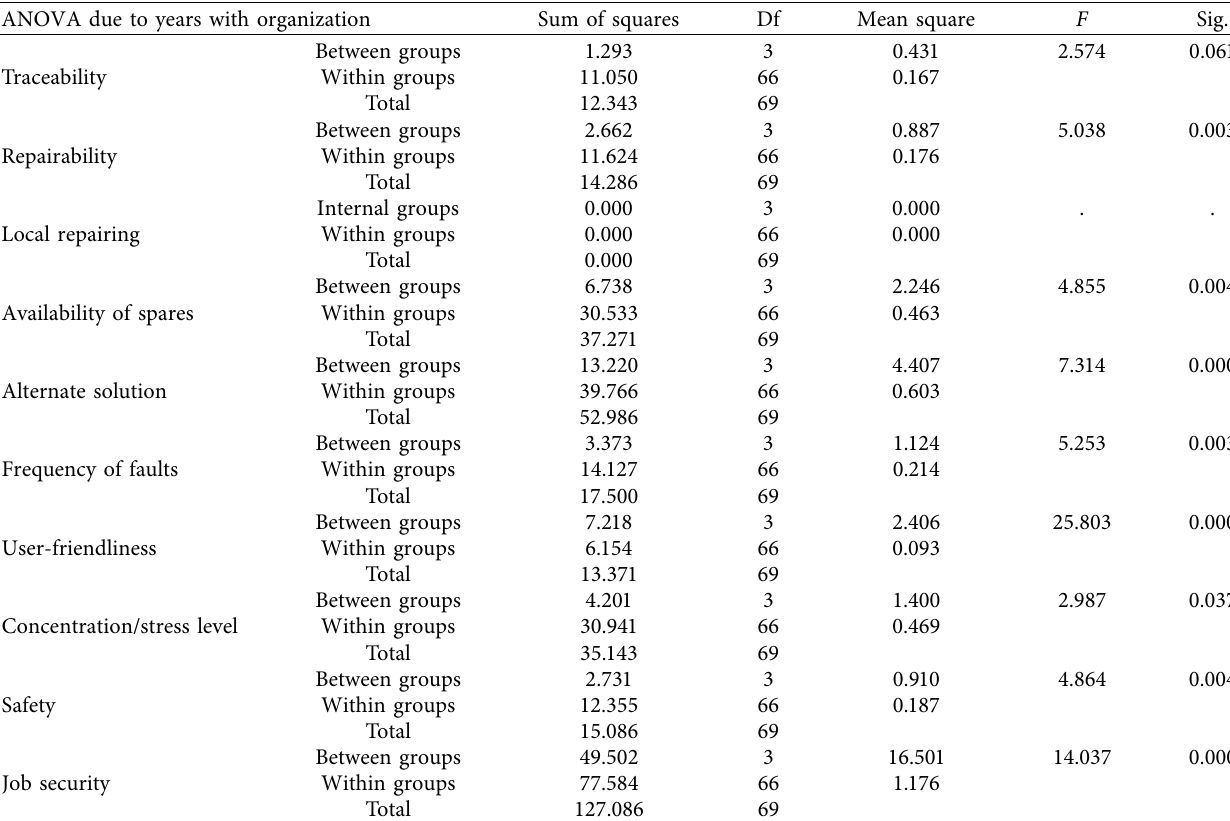
Table 27: ANOVA due to years with organization.